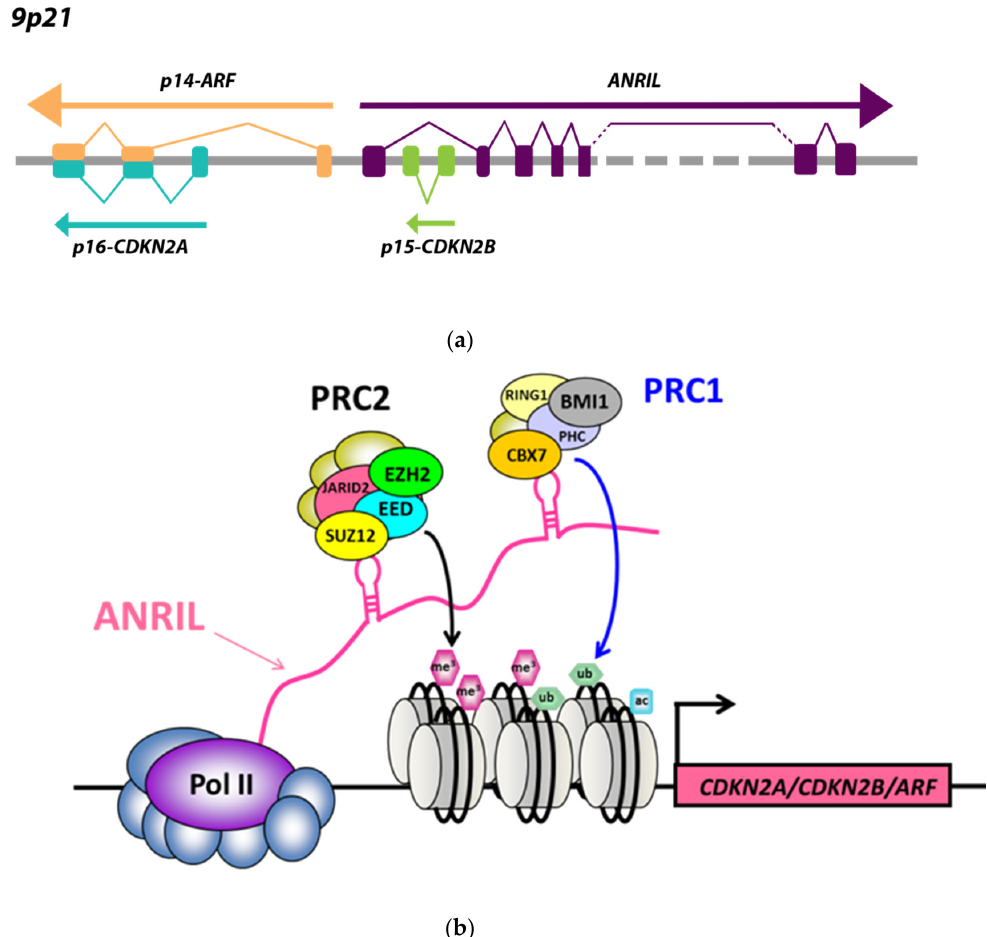
Figure 1. ( a ) ANRIL–ARF bidirectional promoter; ( b ) Interactions between the long non-coding RNA (lncRNA) ANRIL and polycomb PRC2/PRC1 repressive complexes at the p16-CDKN2A/p15- CDKN2B/p14-ARF locus (see Supplementary Table S2).